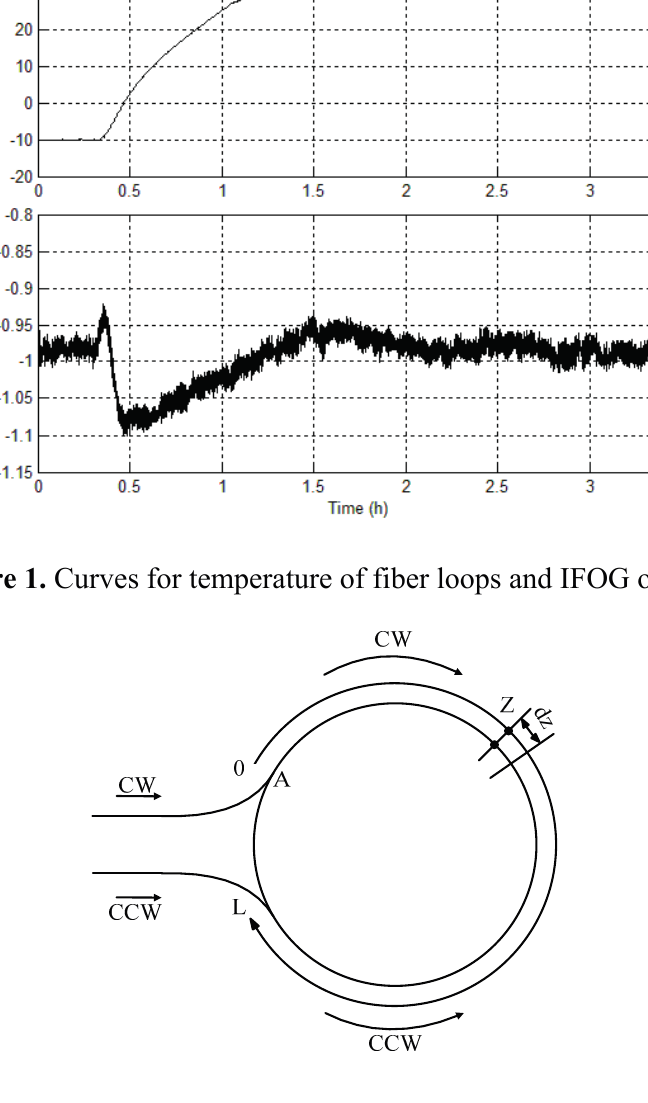
Figure 2. The schematic diagram of fiber